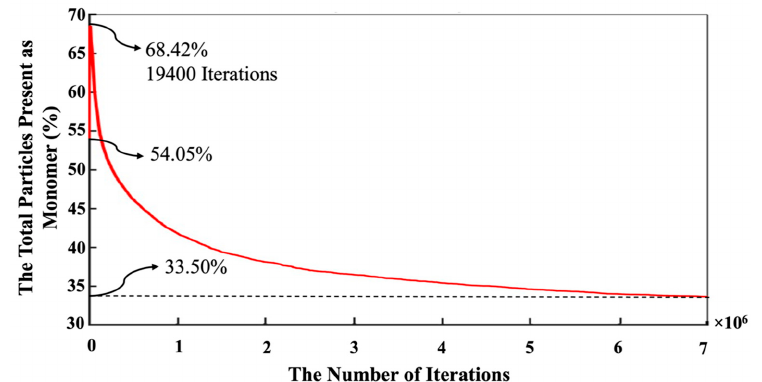
Figure 10. The number of the evolution of monomers in the system during 7 million iterations. The equilibrium condition for the existing monomers was obtained at a percentage of 33.65 after 7 million iterations. Metakaolinite particles were considered (as monomers) at the beginning of the simulation (at zero iteration).